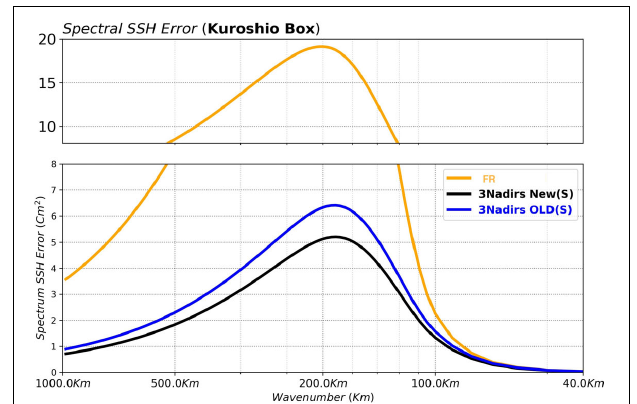
FIGURE 15 | Power spectra of the SSH error with respect to the NR; the spectra are shown in the variance preserving form (cm 2 ). The spatial domain considered is the black box on the previous